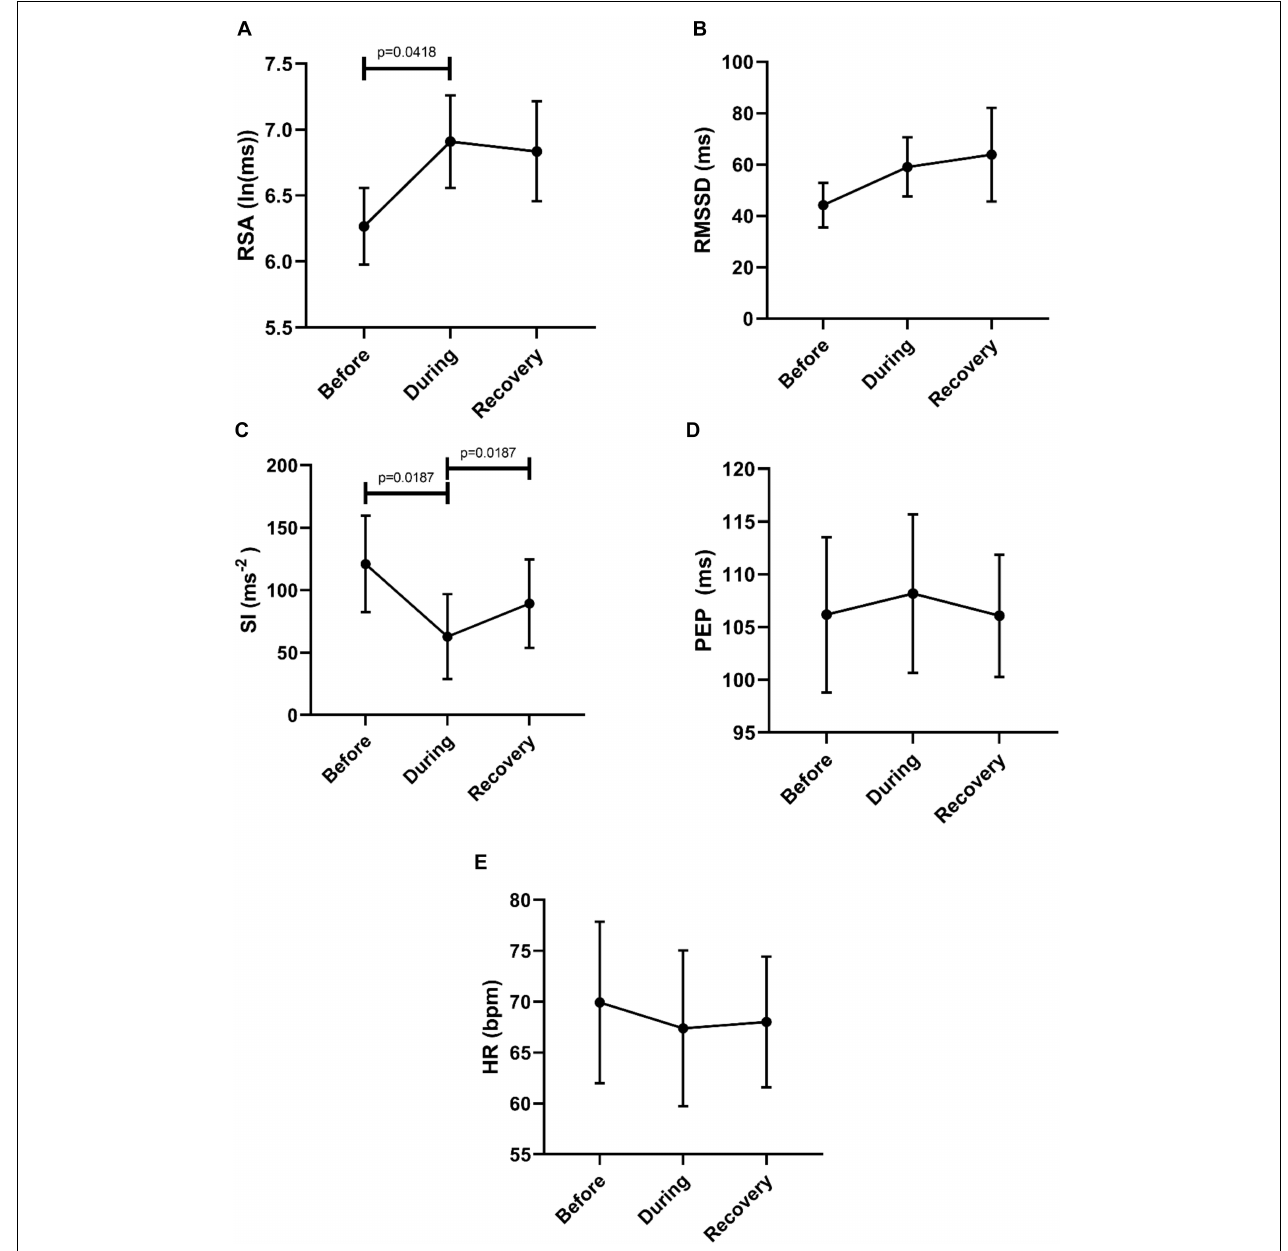
FIGURE 8 | Overall changes in autonomic activity in response to HAPW’s. Data sets are derived by averaging all motor patterns within subjects, hence n = 6). The following HRV parameters were assessed: RSA (A) , RMSSD (B) , the Baevsky’s Stress Index (SI) (C) , PEP (D) , and heart rate (E) . The Friedman test was applied for assessment of significance followed by Dunn’s multiple comparisons test